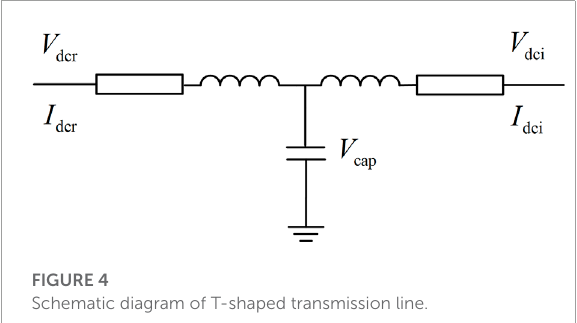
FIGURE 4 Schematic diagram of T-shaped transmission